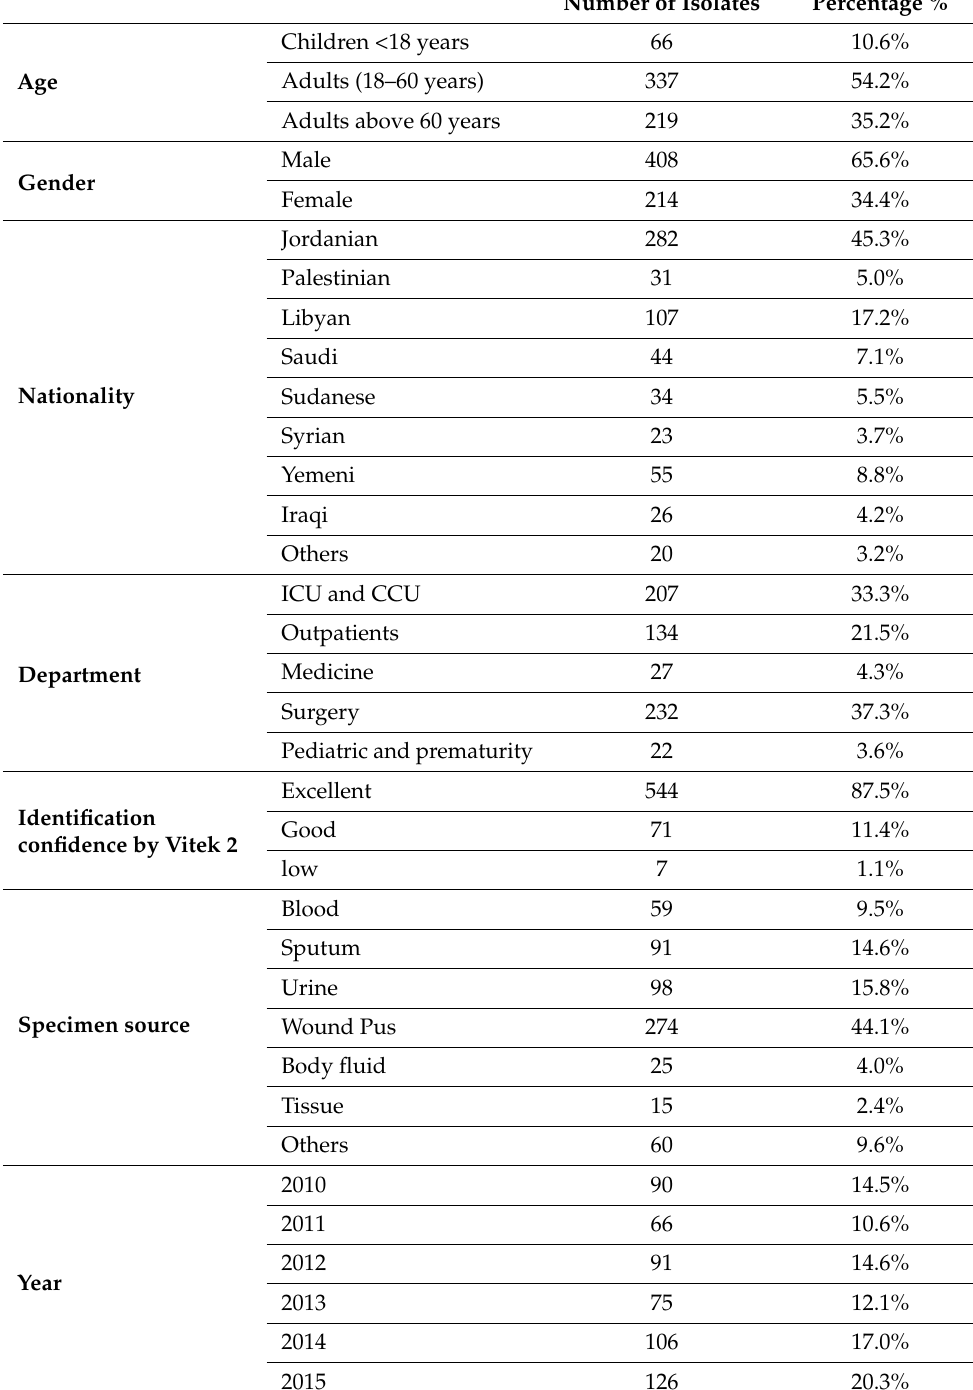
Table 1. Acinetobacter baumannii isolates distribution (Total n =